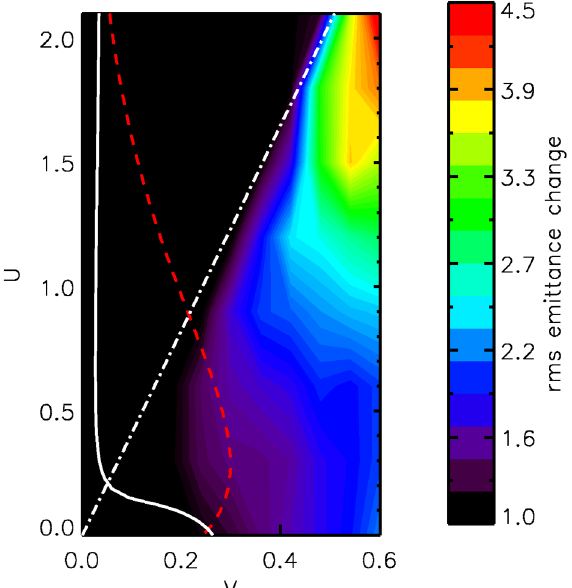
(cid:4) 20 is shown in Fig. 6. r